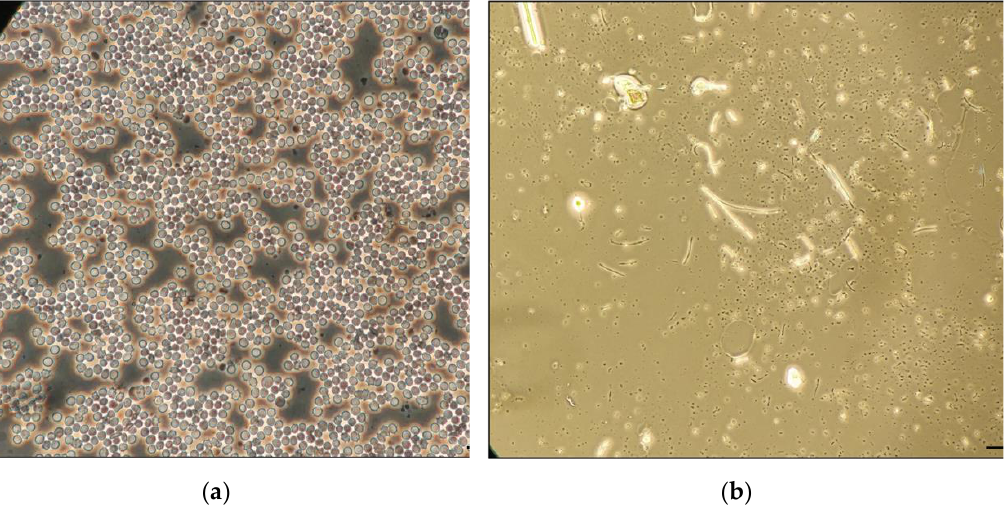
Figure 3. Visual comparison of RBCs content in whole blood versus plasma separated with the pa- per-based BPS device. ( a ) Whole blood sample. ( b ) Plasma sample from BPS device. Table 2. The separation efficiency of RBCs using the BPS device.